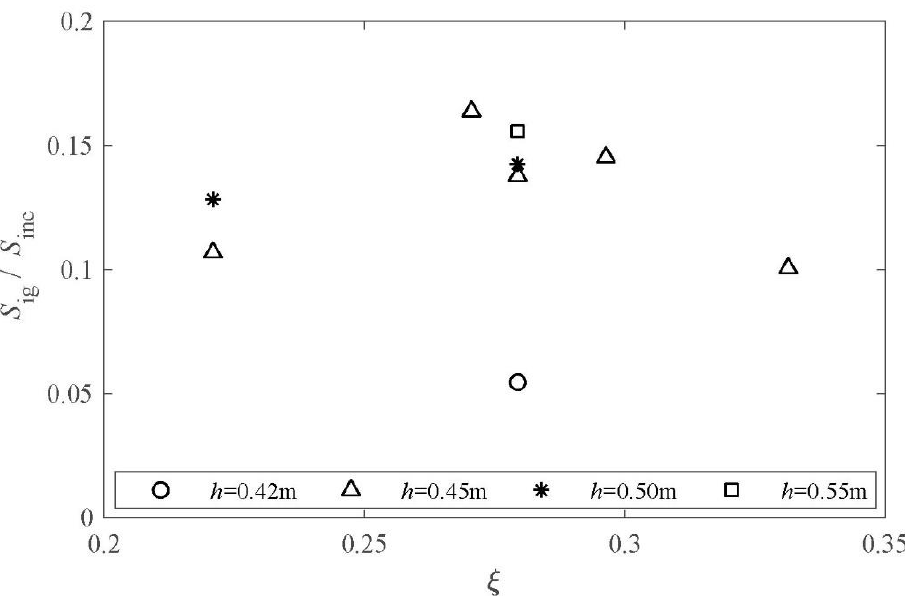
Figure 14. Relationship between surf similarity and the ratio of significant infragravity swash and significant incident swash.